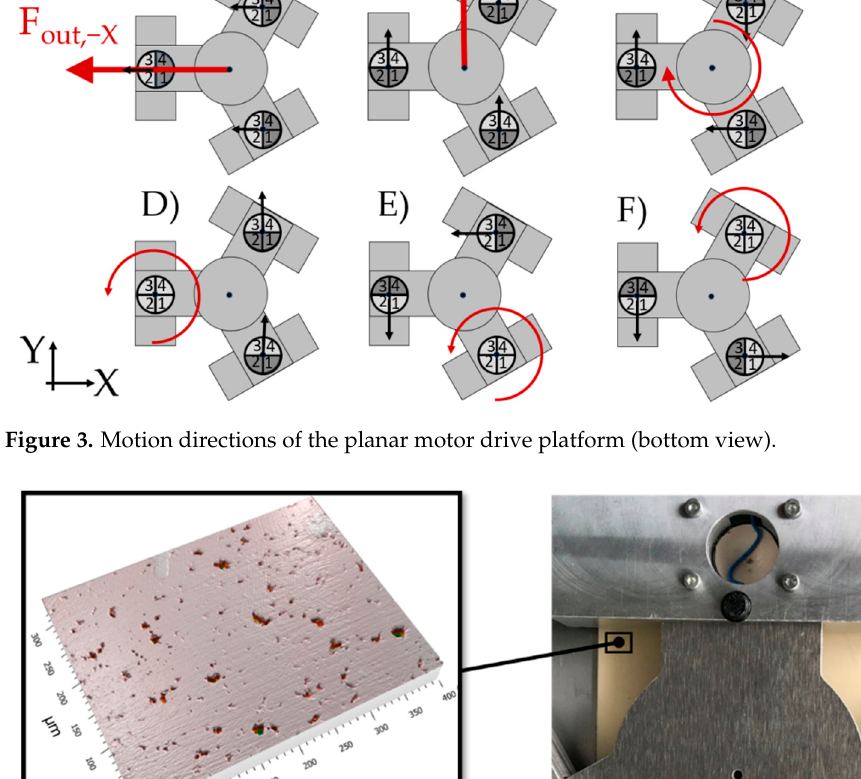
Figure 3. Motion directions of the planar motor drive platform (bottom view).